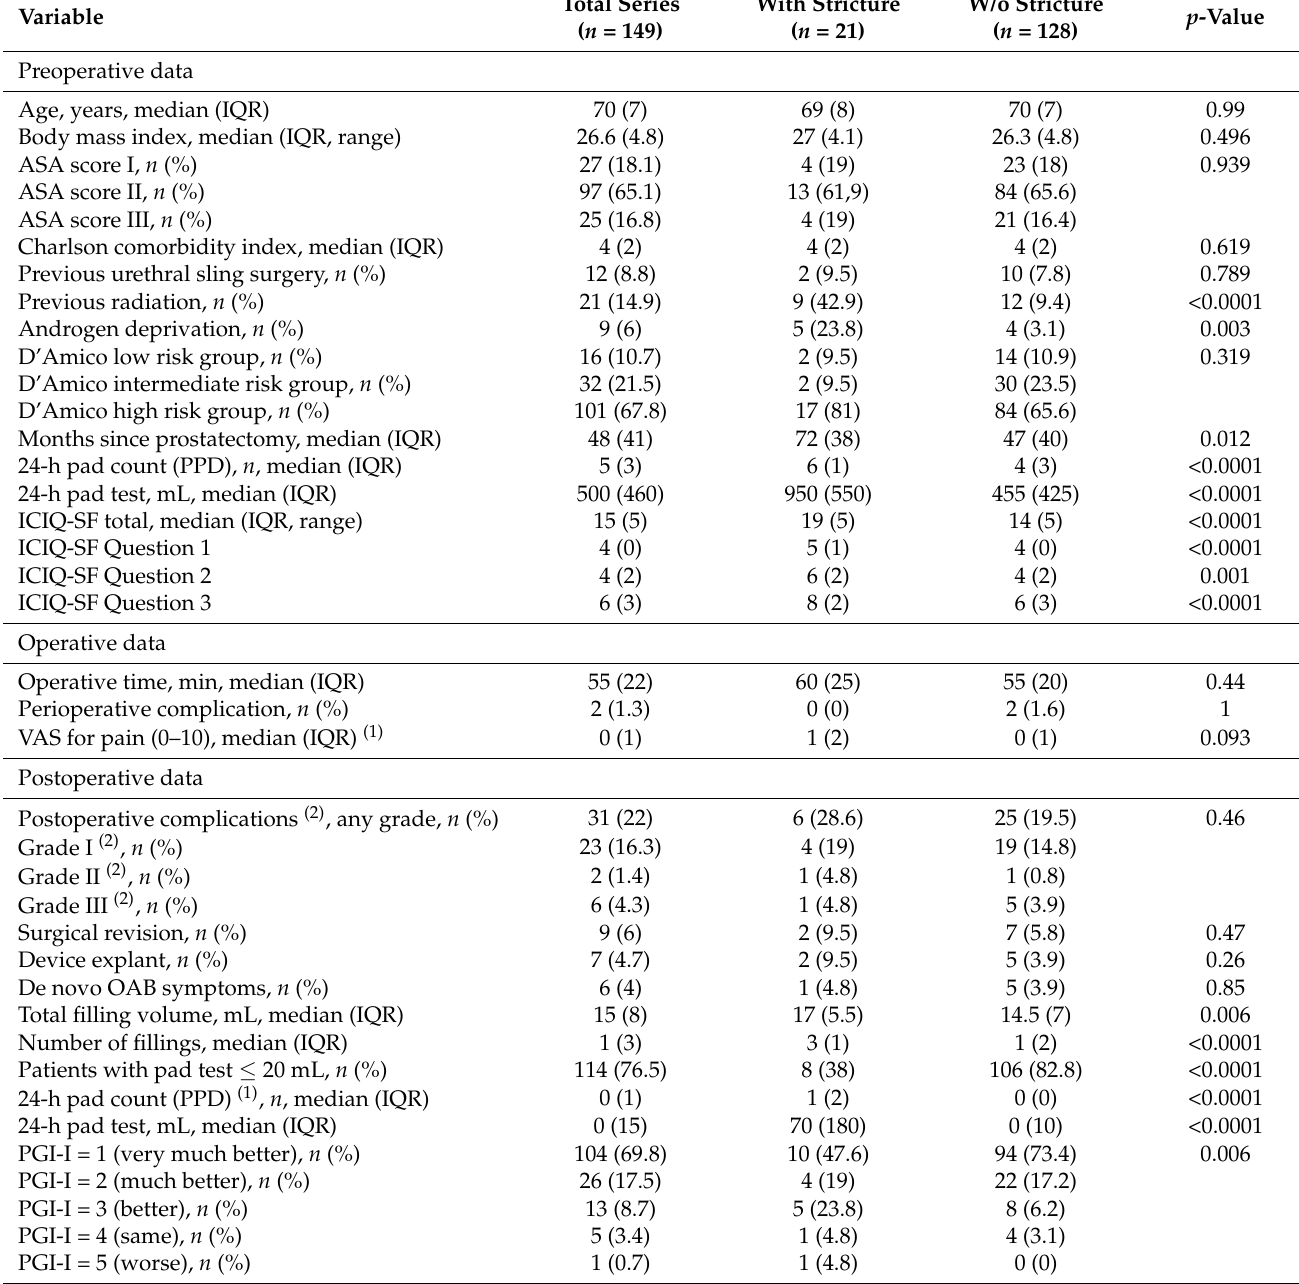
Table 1. Preoperative, operative and postoperative data of the patients included in the study ( n =